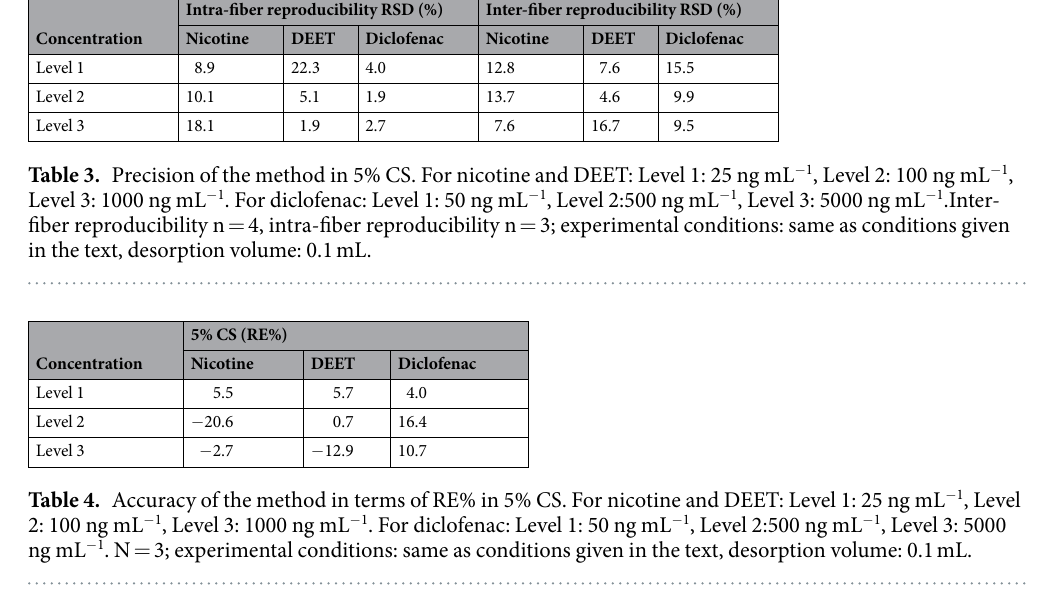
Intra-fiber reproducibility RSD (%) Concentration